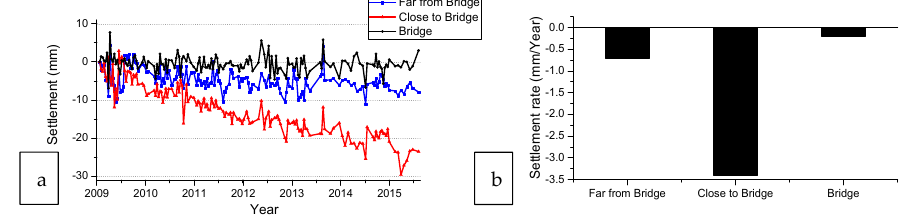
Figure 8. Settlement history of the typical points in the transition zones: ( a ) Settlement history curve; ( b ) Settlement rate.